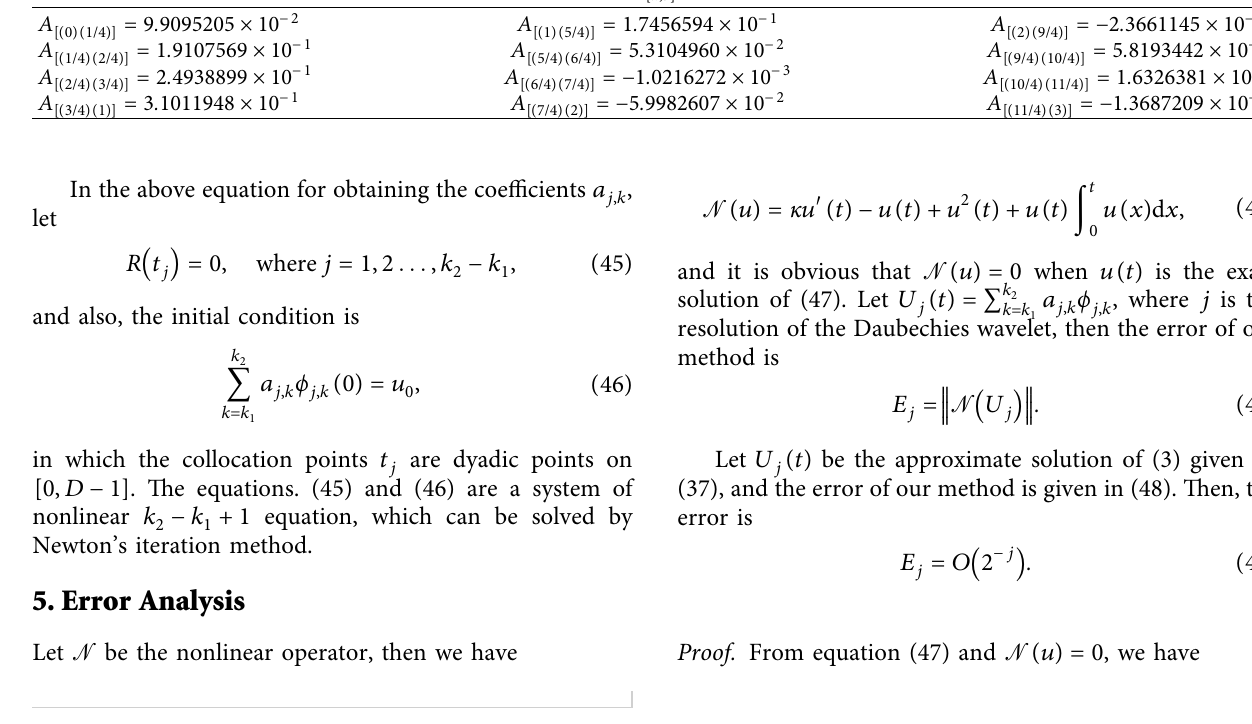
Table 2: The values A